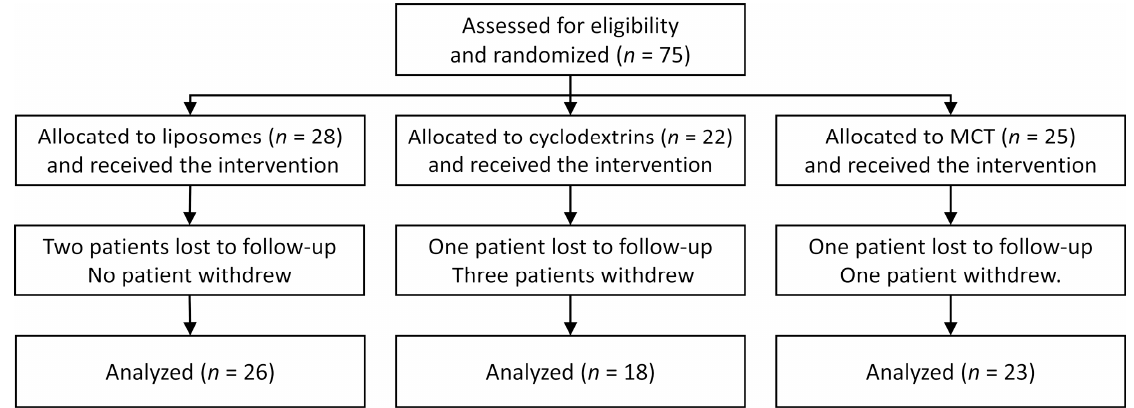
Figure 1. Study flowchart.